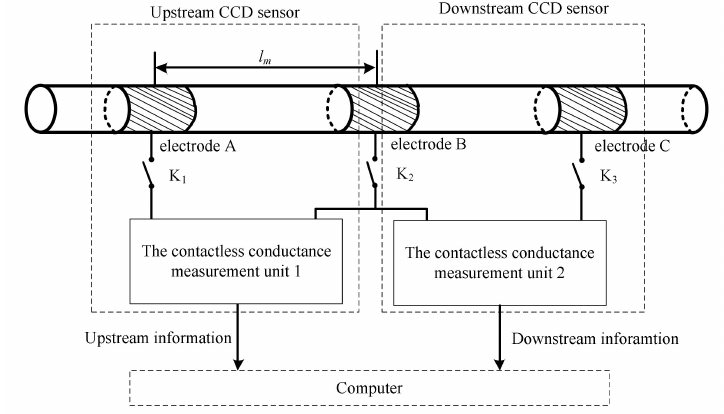
Figure 12. Construction of the velocity measurement system